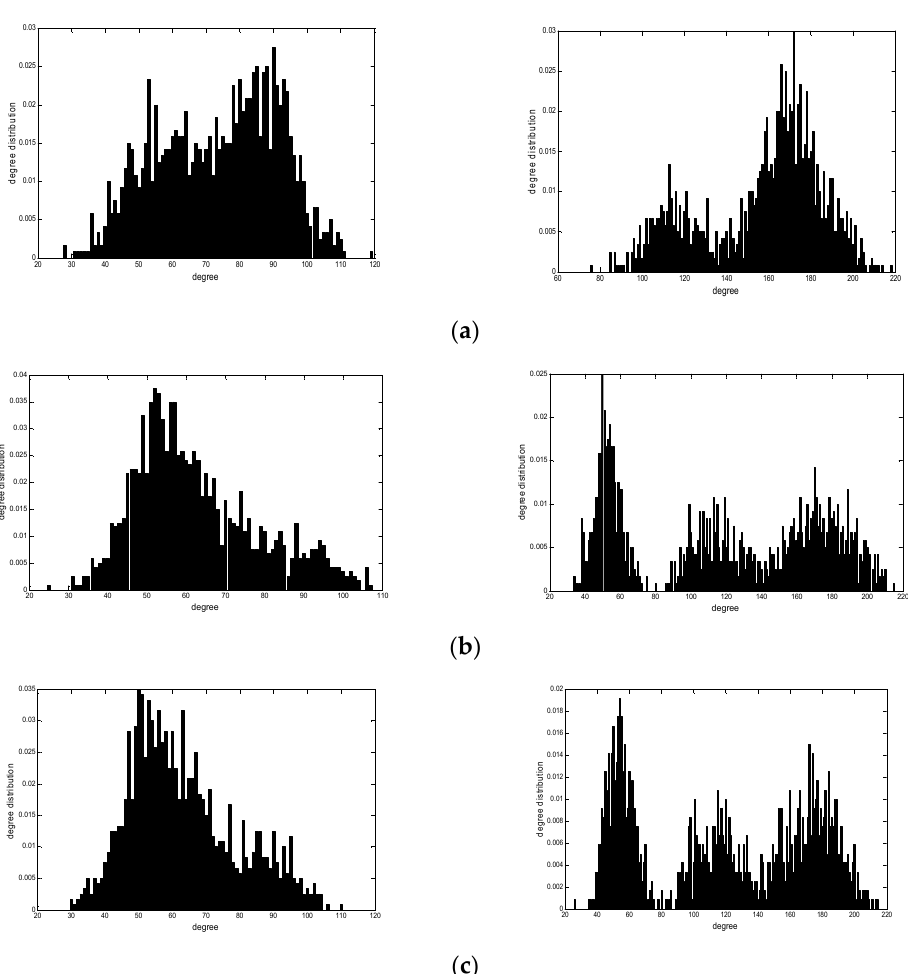
Figure 2. Degree distribution of three-layer EEE networks. ( a ) Degree distribution of three-layer EEE networks; ( b ) degree distribution of three-layer EWE networks; ( c ) degree distribution of three-layer EBE networks. Table 2. The degree distribution characteristics of the three-layer complex networks.